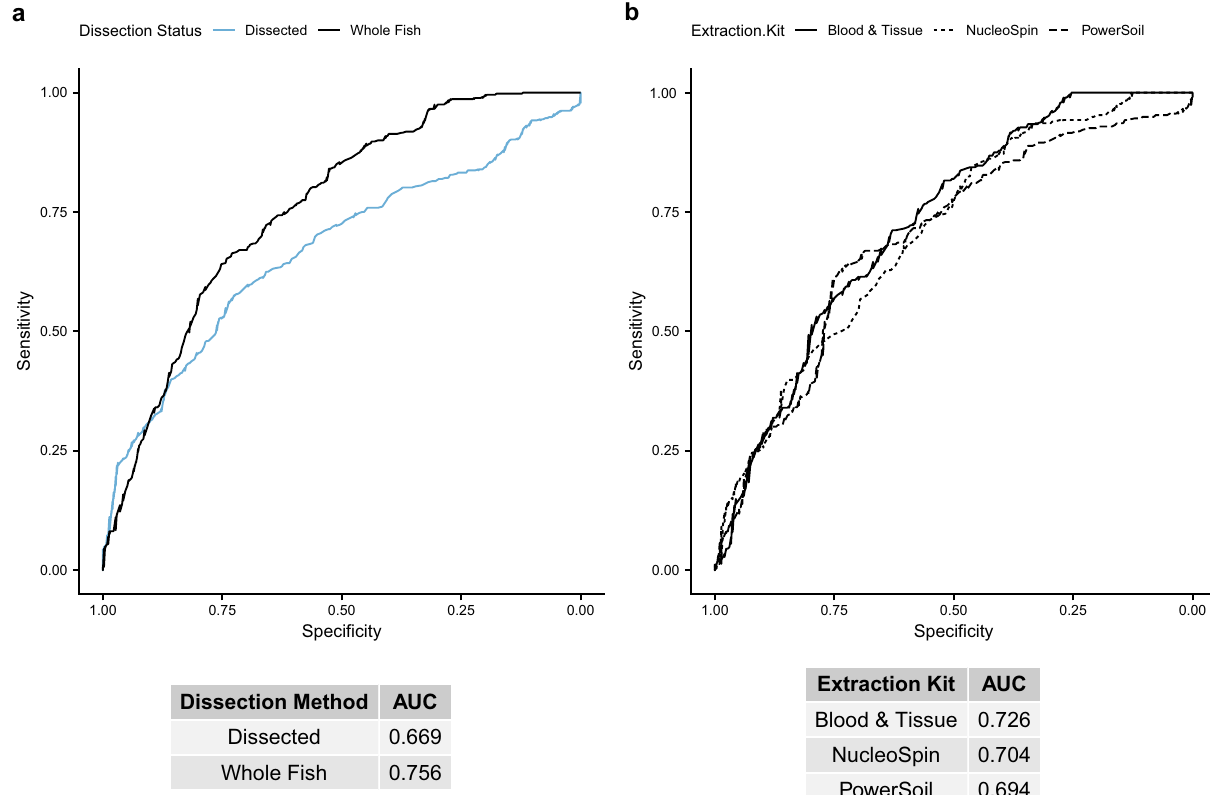
Figure 5. Receiver operating characteristic (ROC) curve plots for random forest models predicting BaP exposure from various data subsets, indicated by line color or line type, of centered log-ratio transformed ASV counts. Tables under each panel indicate the area under the ROC curve (AUC) for each model. A higher AUC indicates a better model, with an AUC of 0.5 indicating a 50% chance (essentially a random guess) of the model correctly predicting BaP exposure from taxon abundances. ( a ) ROC curves for dissected intestine samples (blue line) versus whole fish samples (black line), with the areas under the curve (AUCs) listed in the table below. ( b ) Similar data as in panel a, but for subsets by DNA extraction kit: solid line = Blood & Tissue, short dashed line = NucleoSpin, long dashed line =